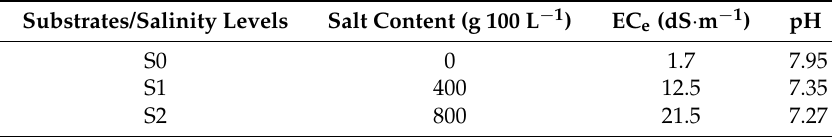
Table 2. Chemical characteristics of the substrates used as